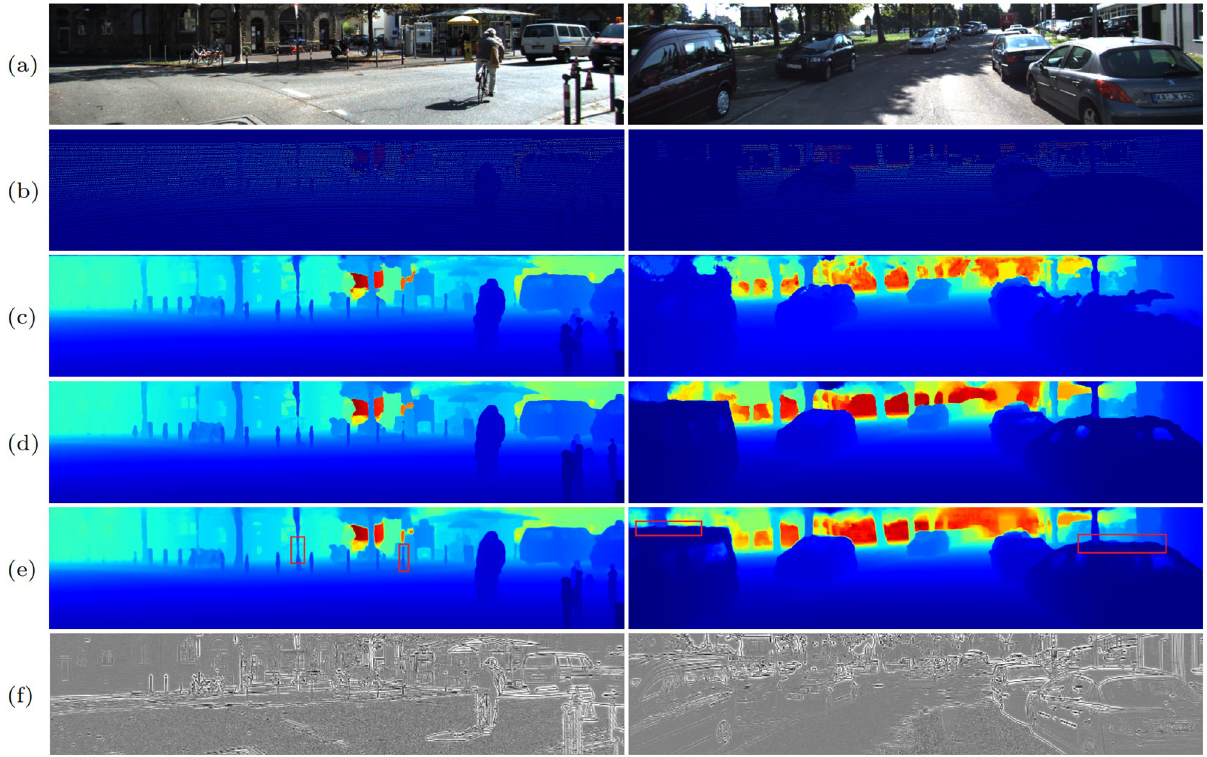
Fig 6. Qualitative comparisons on KITTI DC validation set. (a) RGB, (b) sparse depth, (c) NConv-CNN [60], (d) TWISE [59], (e) SPNet (ours), (f) gradients from RGB